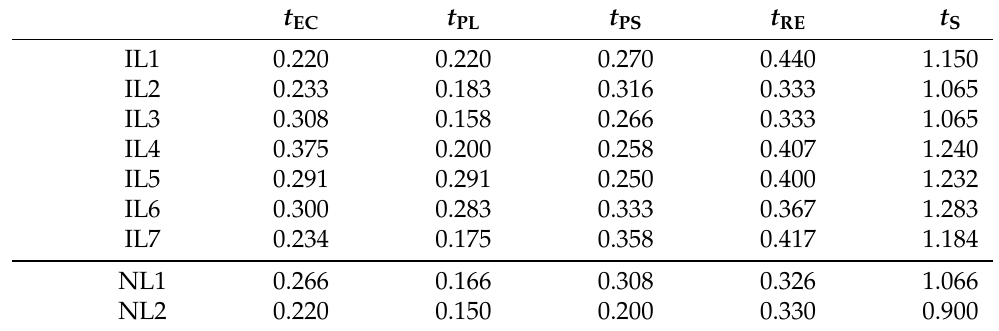
Table 1. Experimental data for swimmers IL1–IL7 and NL1–NL2: arm phase durations (in seconds).